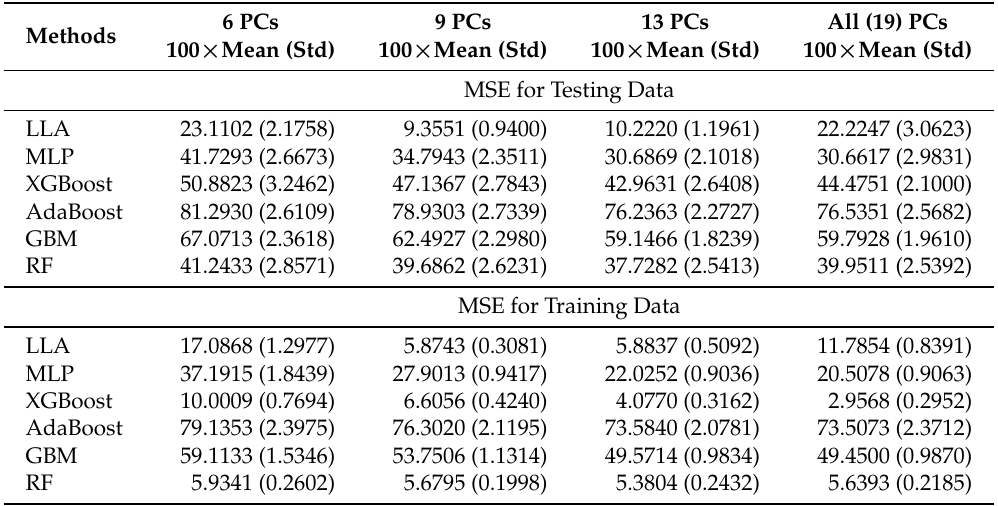
Table 2. Comparison of the impact of PCA on LLA and existing procedures based on PK data. 6 PCs 9 PCs 13 Methods